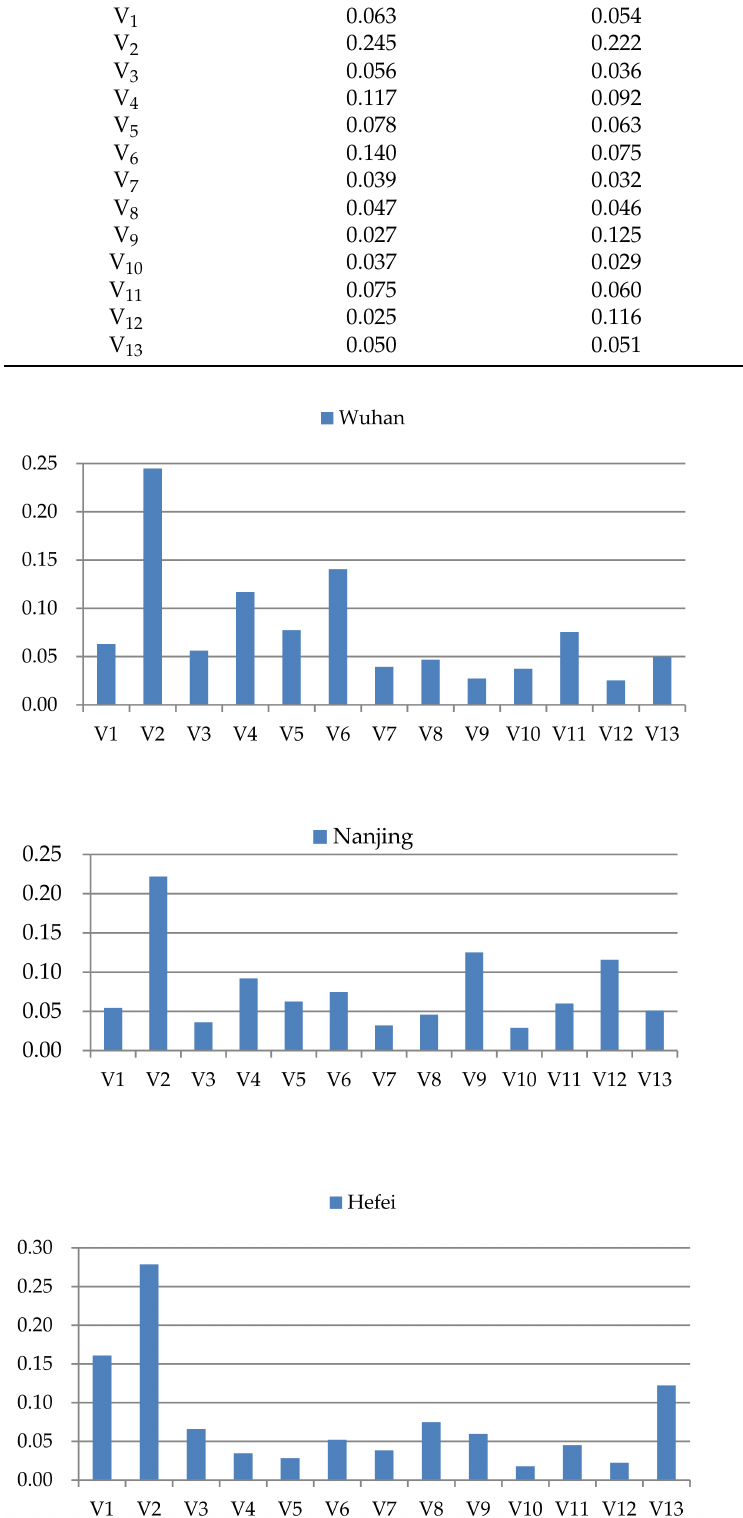
Figure 6. Comparison of resilience indicators in three